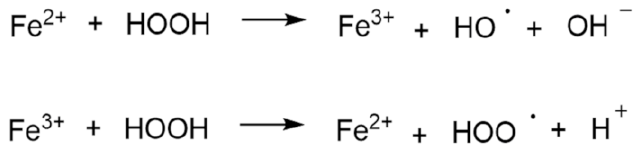
Figure 9. The Fenton